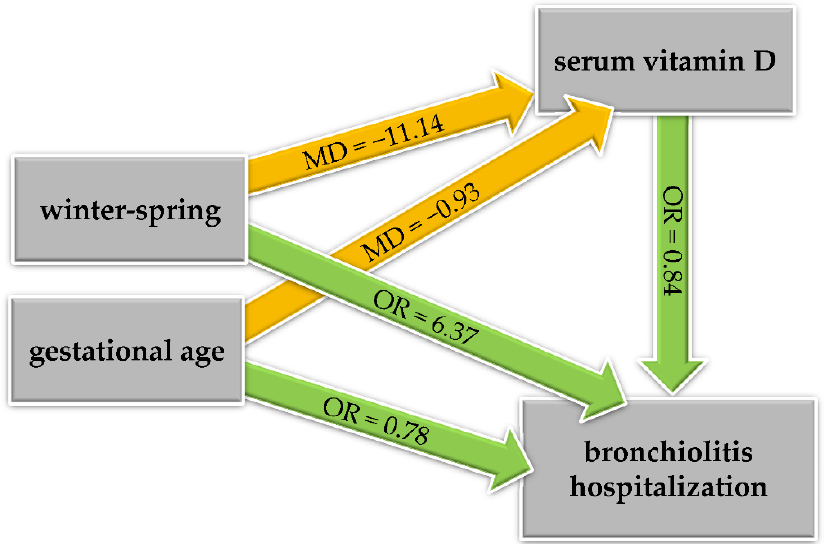
Figure 3. Directed acyclic graph illustrating the mediation analysis. MD: mean difference (orange); OR: odds ratio (green).